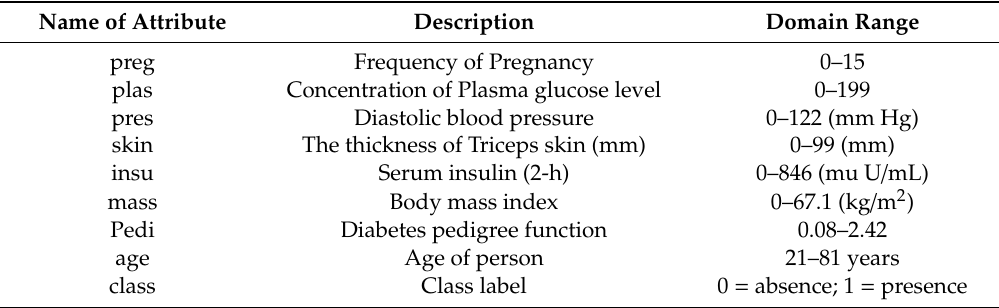
Table 3. PIMA Indian dataset details [79]